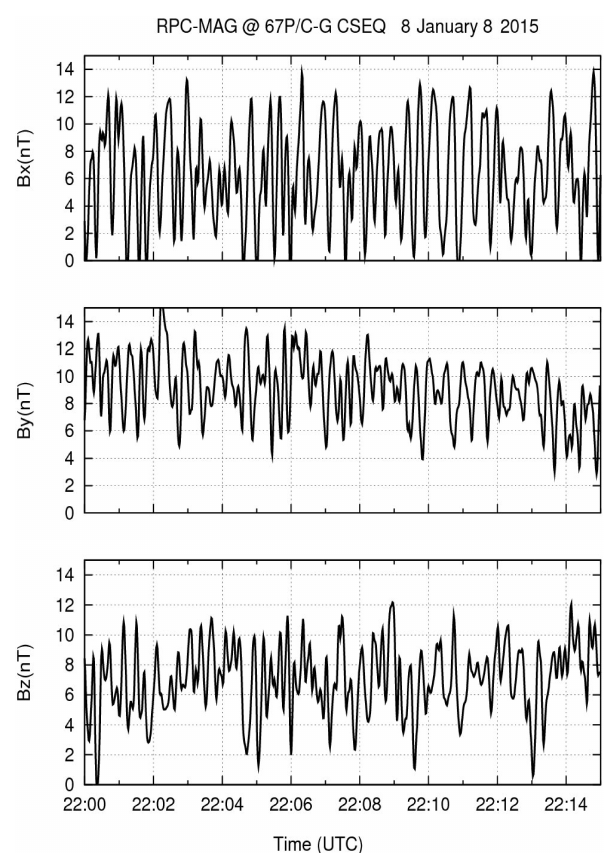
Figure 1. Magnetic field measurements made by RPCMAG on 8 January 2015, 22:00–22:15UTC, as an example for the detection of low-frequency waves. Large-amplitude waves with a frequency of 28mHz are clearly visible. The spacecraft position at that time was (0.2, − 27, 5)km in the CSEQ-coordinate